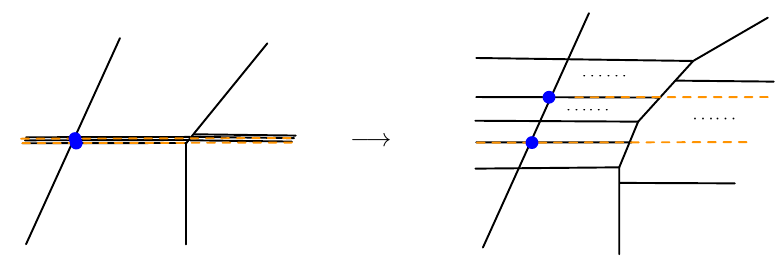
Figure 19 . This web describes the real mass deformations of the theory U(2) k + N f F + N a AF . The mass deformations for higher rank U( N ) theories are